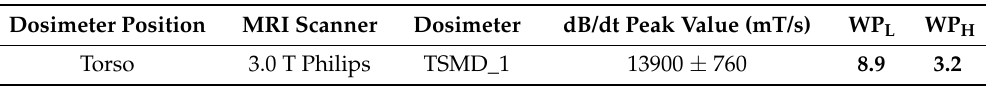
Table 6. dB/dt peak values and WP L and WP H indexes are reported. Bold values indicate noncompliance with regulatory